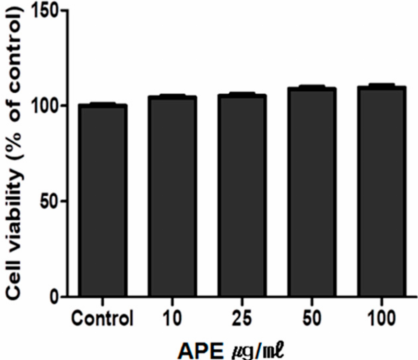
Figure 1. Cytotoxicity test of APE on GT1-7 cells. GT1-7 cells were seeded in a 96-well plate and then treated with APE at 10–100 µ g/mL to evaluate its cytotoxic